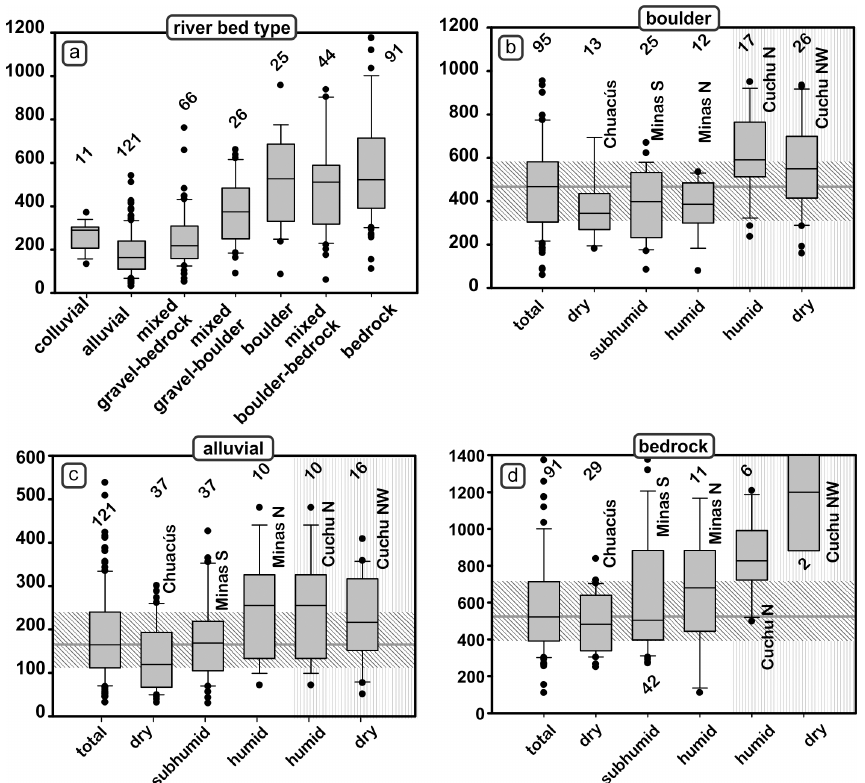
Figure 14. Box plots of stream segment normalized steepness as a function of streambed type and location. (a) Comparison of steepness by streambed environment. (b–d) Spatial variations in channel steepness across the study area, according to regions defined on Fig. 7, for the three main types of streambed environment: (b) boulder, (c) alluvial, and (d) bedrock. Numbers above box plots show the number of segments in each category. Oblique hatches show the average over the total number of segments. Vertical hatches show the rapidly uplifting AC